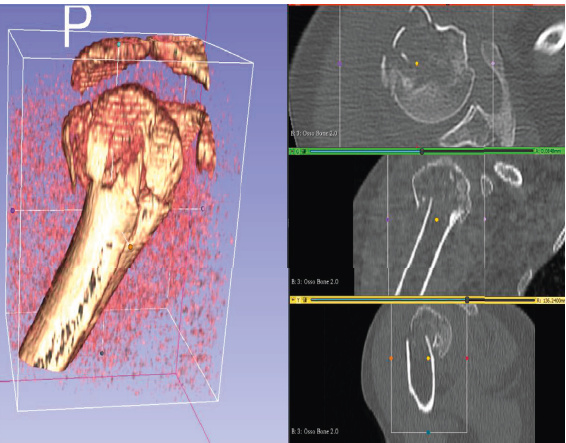
Figure 3: Slicer software user interface showing the segmentation process of a 3D digital model from a CT scan of PHF.